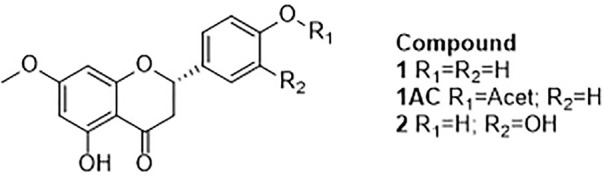
Compounds studied by ECD.